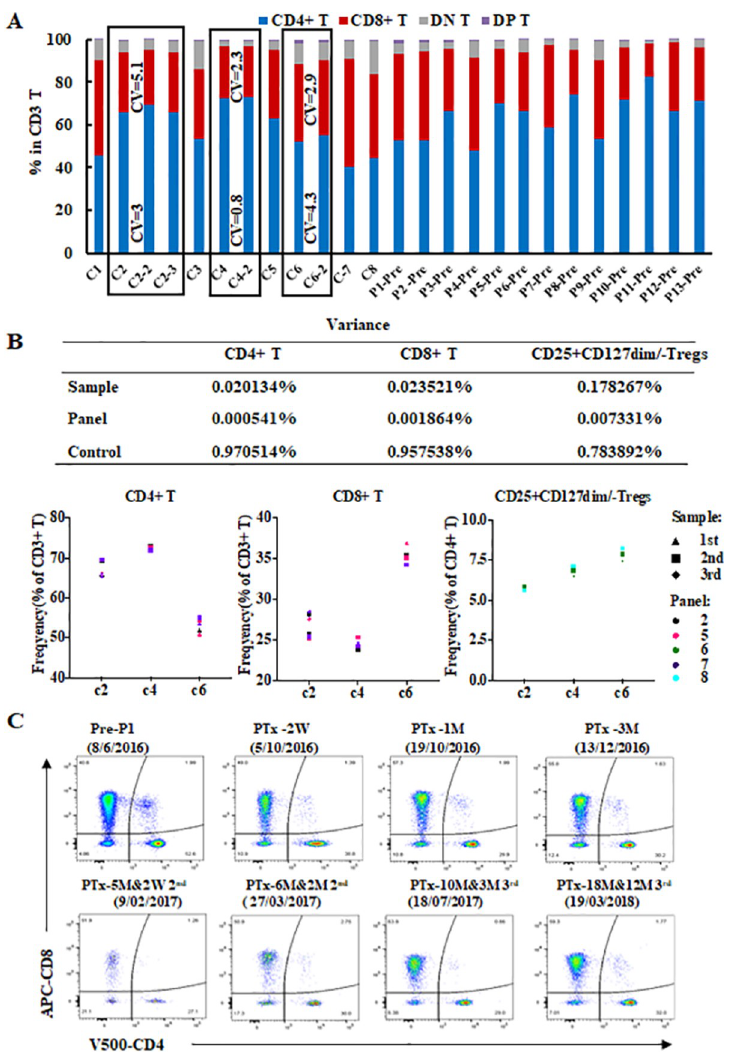
Fig 7. Evaluation of T subsets were consistent and reproducible over a 21 month period. (A) The percentage of CD4+, CD8+, CD4+CD8+, CD4-CD8- within the total CD3 T cell population in 12 samples of 8 healthy controls and 13 T1D patients pre-islet transplantation (panel 2). Three healthy-controls (C2, C3 and C6—bold rectangles) had data at 3 or 2 separate time points more than 3 months apart. The CV values of CD4+ and CD8+ T cell frequencies were 3 and 5.1 for C2, 0.8 and 2.3 for C3, and 4.3 and 2.9 for C6 respectively among the different time points ( � 2 time points). (B) The variances in the proportion frequencies in CD4+ and CD8+ T cell, and CD25+CD127- Treg population frequencies explained by differences on control sample over time (2 or 3 time points) and across panels (panel 2, 5 and 7 for CD4+ and CD8+ T cells, and panel 6 and 8 for CD25+CD127dim/- Tregs), and between controls (C2, C4 and C6) using three-way ANOVA. (C) The comparison of CD4 vs CD8 in panel 2 from patient 1 (P1) pre-transplantation, 2 weeks (W), 1 and 3 months (M) after the first islet transplantation, and 2 weeks, 2 months after the second islet transplantation, and 3 and 12 months after the third islet transplantation which occurred across a 21 month time period. This showed that the four subsets of CD3+ T cells (CD4+CD8-, CD8+CD4-, CD4+CD8+, CD4-CD8-) were consistently detected pre and